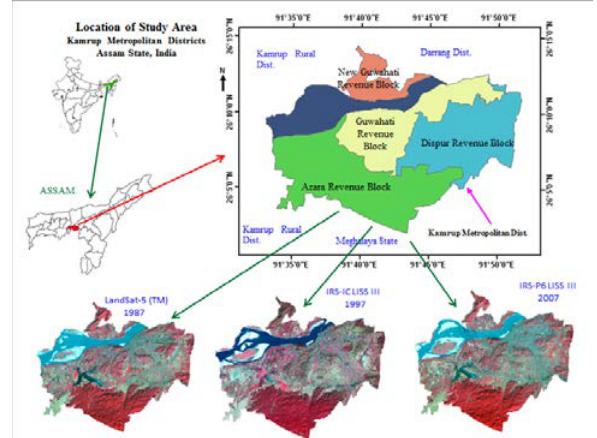
Figure 1: Location and satellite images of study area